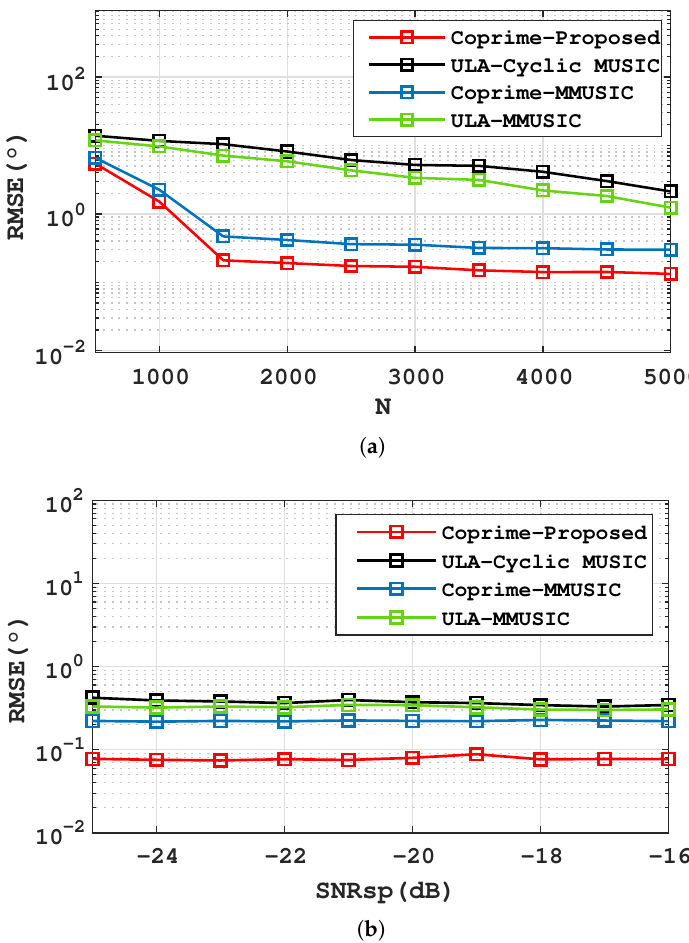
Figure 5. Accuracy comparison results. ( a ) RMSE versus N ; ( b ) RMSE versus